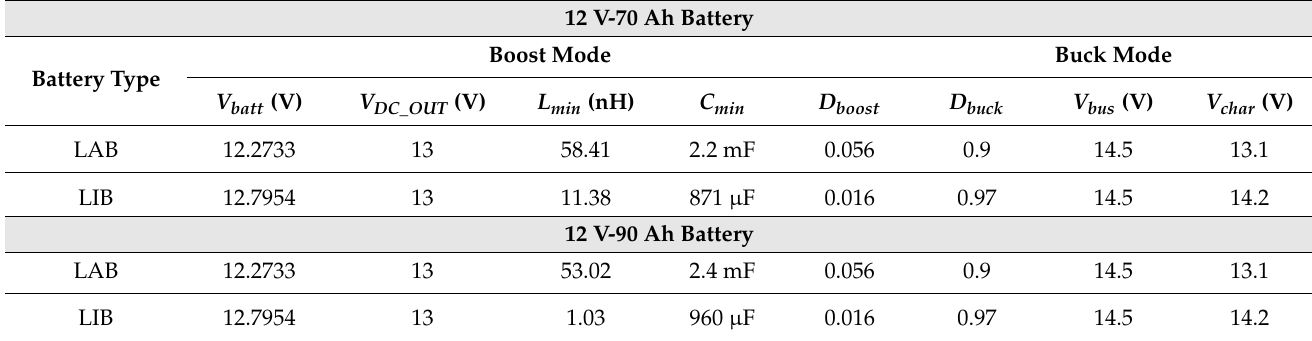
Table 1. Summary of converter parameters for battery capacities under study.